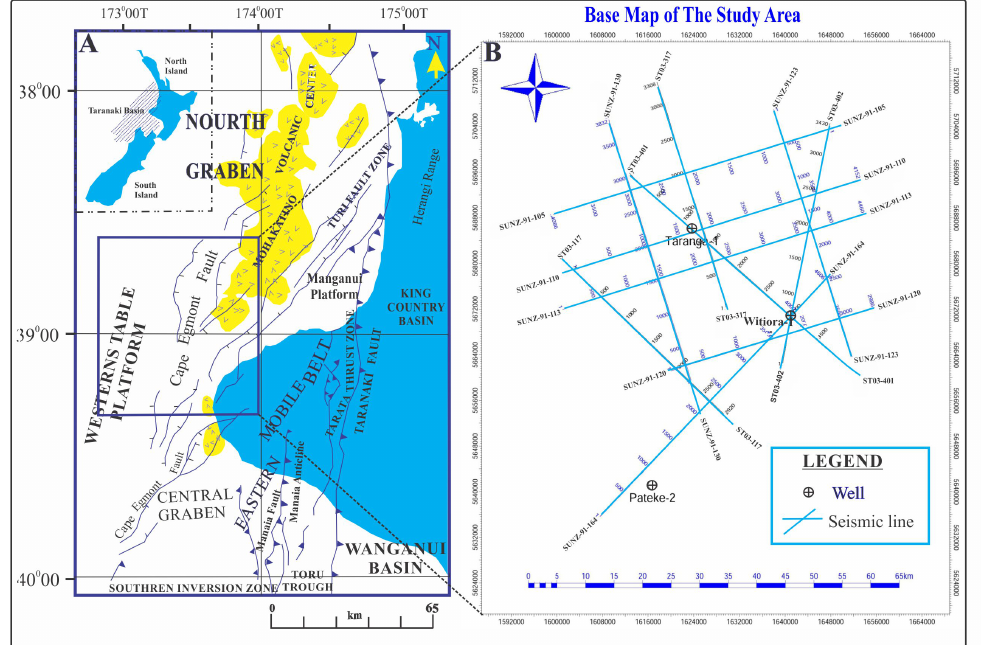
Figure 1. The study area of the Taranaki basin with seismic lines and wells location